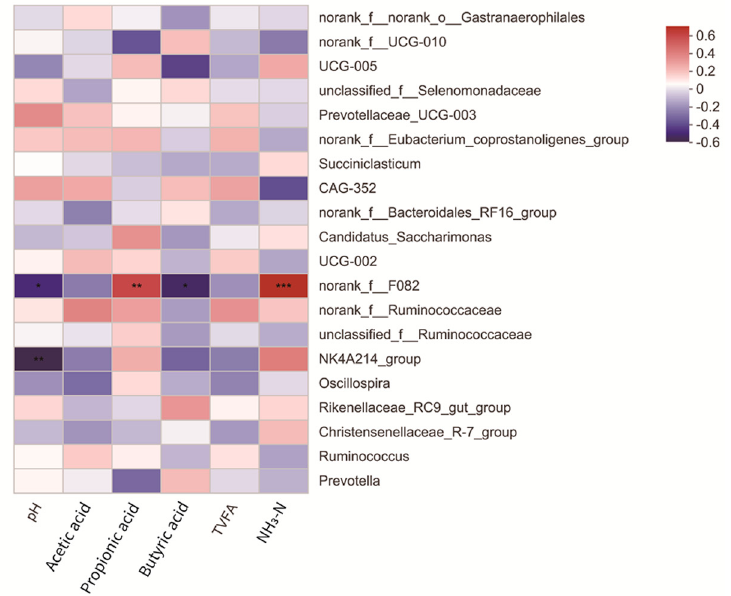
Figure 5. Relationship between environmental variables and microbial diversity and abundance. R values are displayed in different colors, *, ** and *** represent p < 0.05, 0.01 and 0.001, respectively, and the legend on the right is the colour interval of different R values.